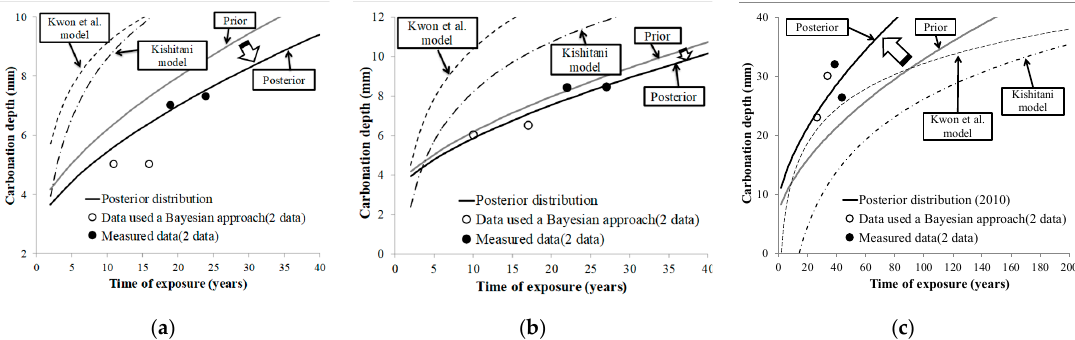
Figure 7. Changes in prior and posterior predicted values for carbonation depth of the subject bridge. ( a ) Gajwa IC viaduct; ( b ) Noryang bridge; ( c ) Geoje bridge.